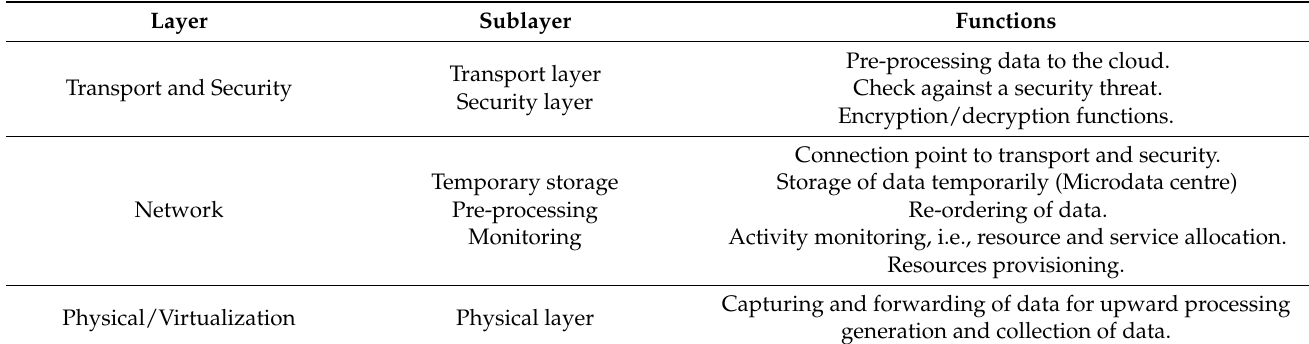
Table 3. The various layers and sub-layers of Fog computing, as well as their functionalities.